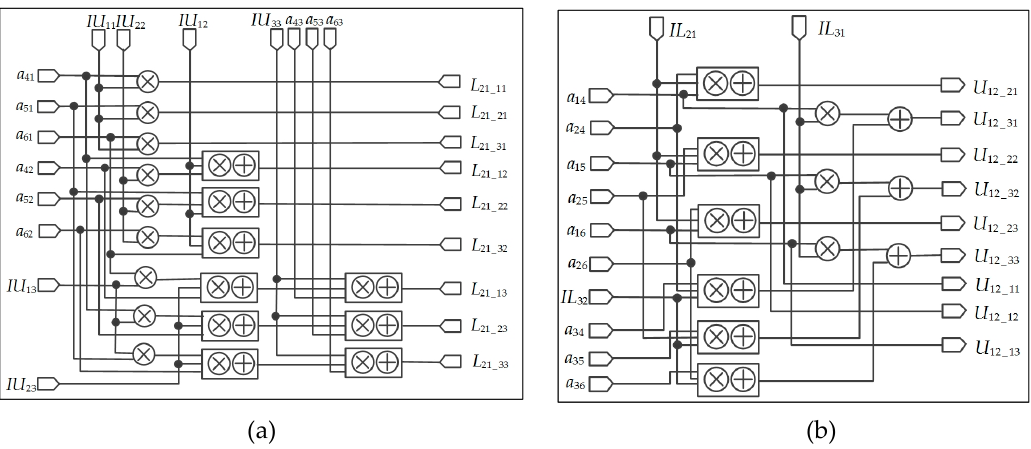
L . ( b ) The architecture 21